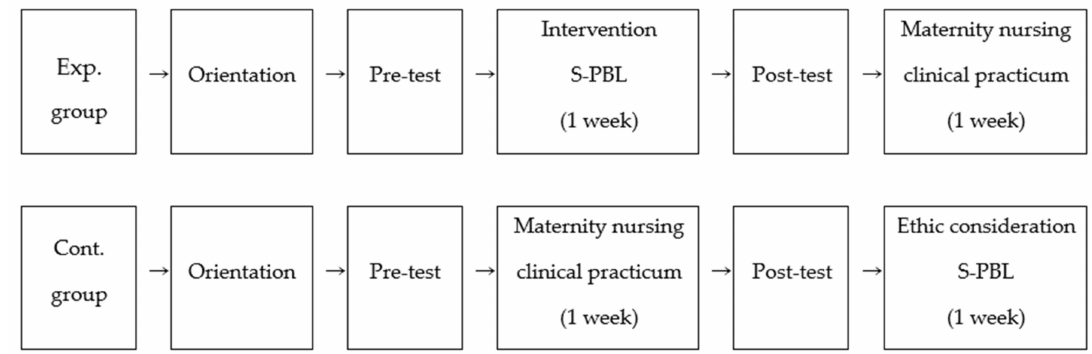
Figure 2. Research design. Exp. group = experimental group, Cont. group = control group; S-PBL = Simulation problem-based